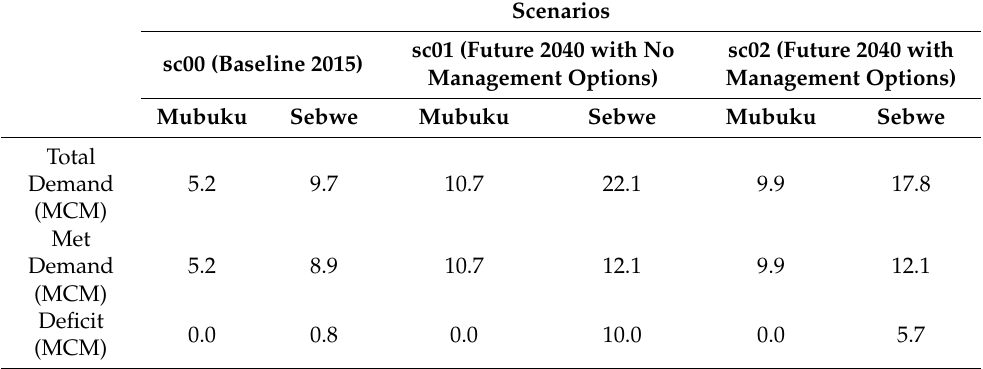
Table 11. Annual water demand